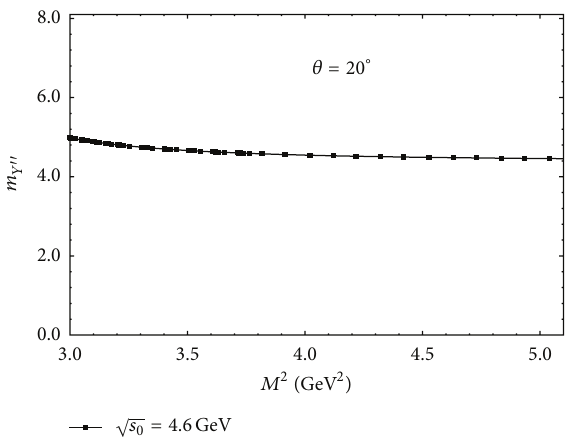
Figure 3: The dependence of the mass of the 𝑌 󸀠 state on Borel mass square 𝑀 2 for the mixing angle 𝜃 = 20 0 , at the fixed value of the continuum threshold √𝑠 0 = 4.4 GeV.